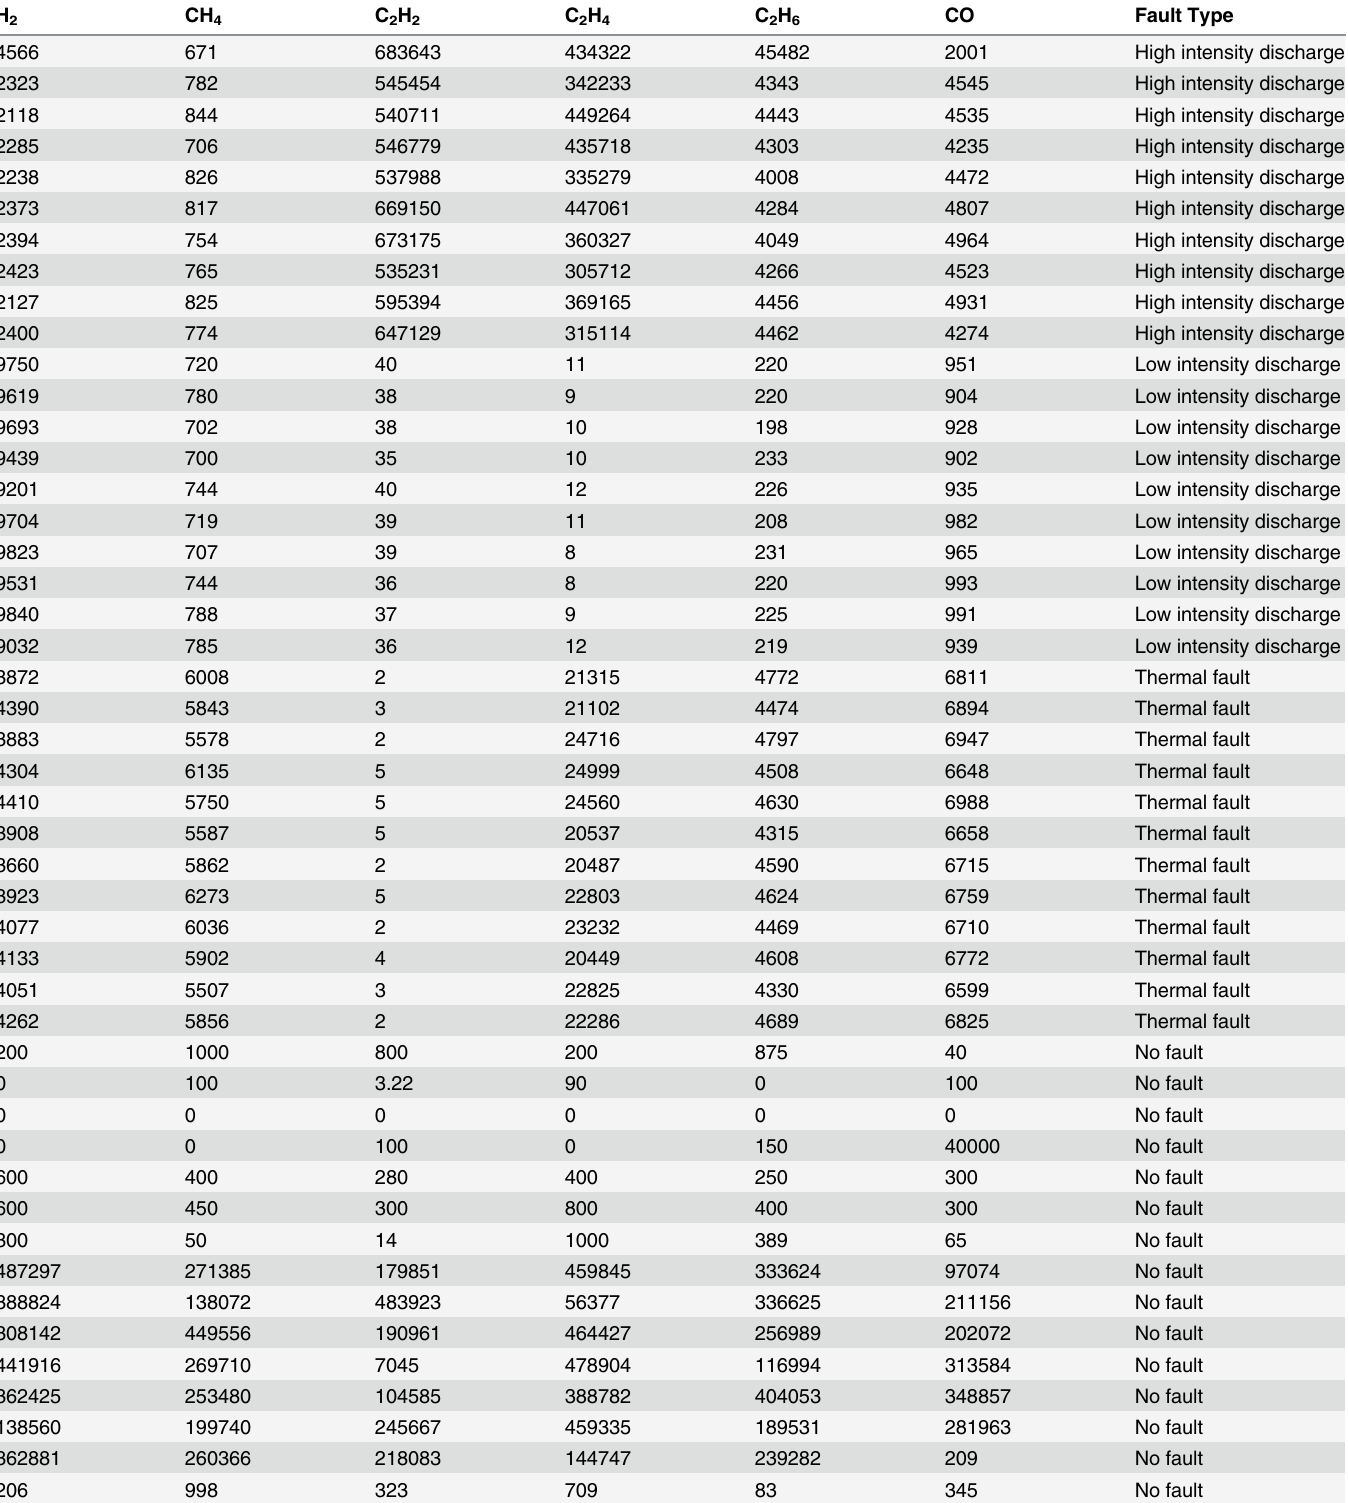
Table 1. Some actual data of incipient transformer fault from an electrical